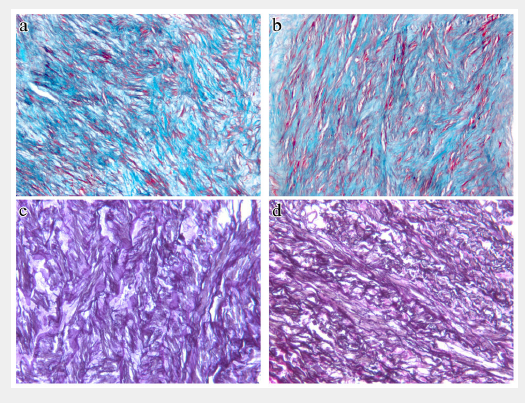
Representative sections of aorta stained with Masson’s demonstrate increased collagen and disorganisation of smooth muscle and collagen in the media of the aortic wall of hypertension patients (a), as compared with non-hypertension patients (b). Collagens are stained green and smooth muscle is stained red. Magnification x200. Representative sections of aorta stained with Weigert’s demonstrate decreased elastin and disorganisation of the elastic network in the media of the aortic wall of hypertension patients (c), as compared with non-hypertension patients (d). Elastins are stained black. Magnification